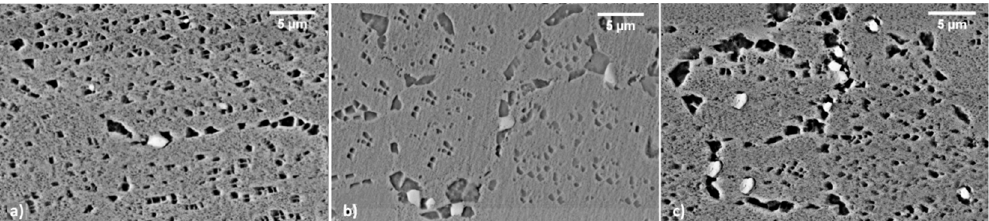
Figure 10. LT samples after solutioning ( a ) after first aging ( b ) and after second aging ( c ).